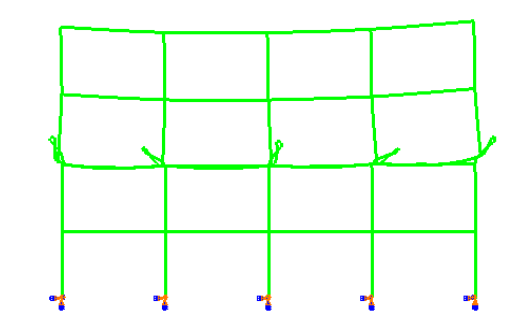
Fig. 13. Final state of 5-storey frame in horizontal fire